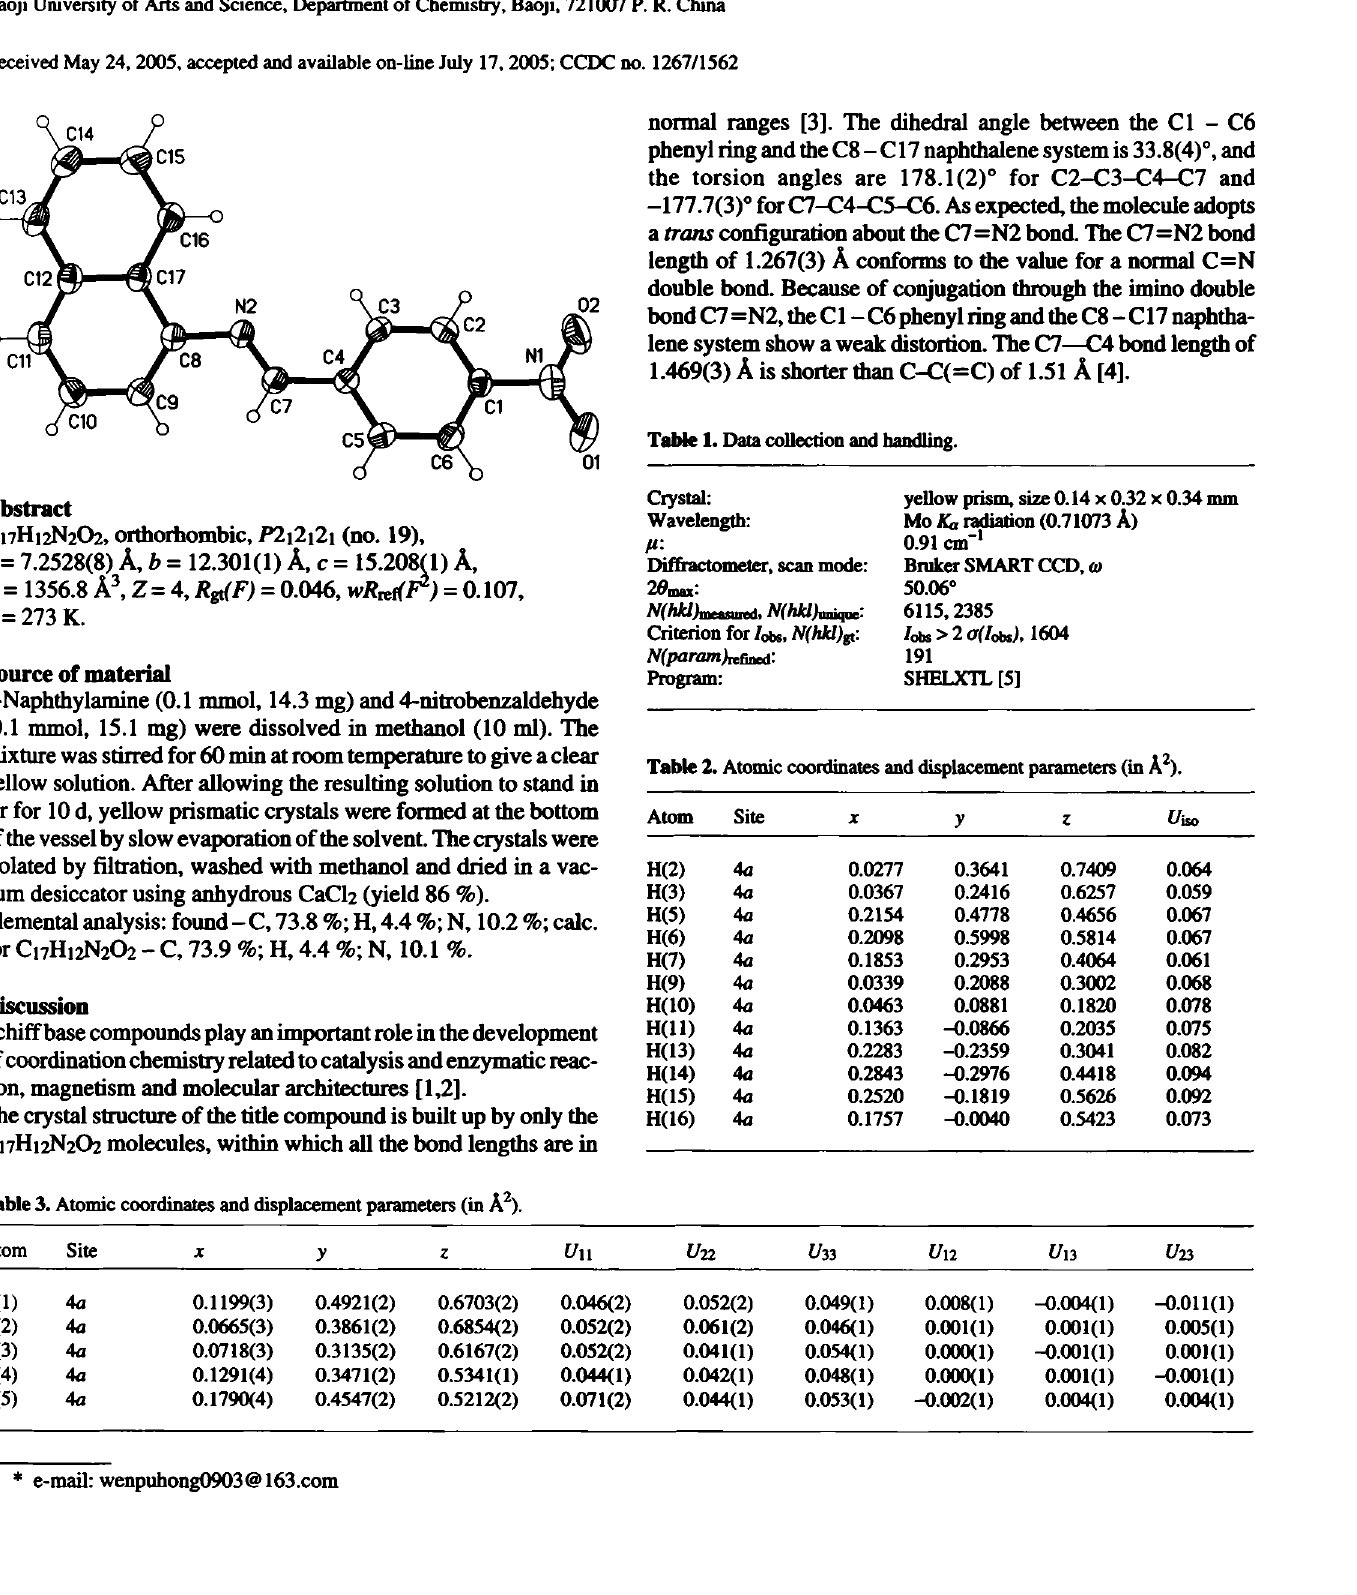
Table 1. Data collection and handling.